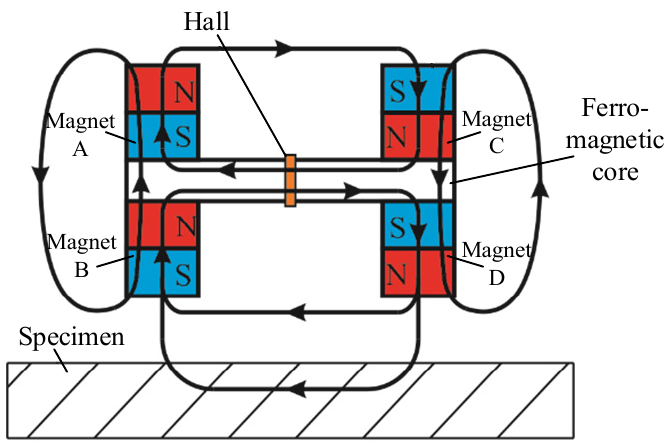
Figure 1. Schematic of the bridge-structured PM-MFM sensor.